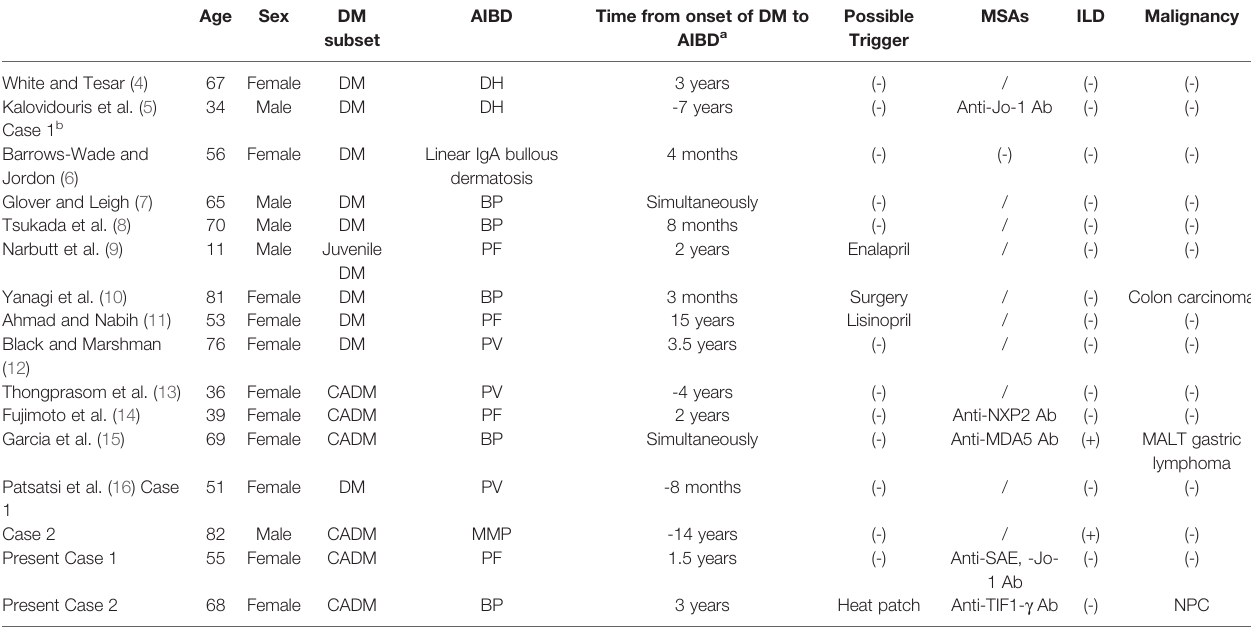
DM,dermatomyositis;AIBDs,autoimmuneblisteringdiseases;MSA,myositis-speci fi cantibody;CADM,clinicallyamyopathicdermatomyositis;ILD,interstitiallungdisease;DH,dermatitis herpetiformis; PV, pemphigus vulgaris; PF, pemphigus foliaceous; BP, bullous pemphigoid; MMP, mucous membrane pemphigoid; NPC, nasopharyngeal carcinoma; MALT, mucosa- associated lymphatic tissue; NXP2, nuclear matrix protein 2; MDA5, melanoma differentiation-associated gene 5; SAE, small ubiquitin-like modi fi er activating enzyme; TIF1, transcription intermediary factor 1. a Time span from the onset of fi rst symptom assumed to be related to DM to AIBD, the symbol “ - ” means AIBD occurred before DM. b Case 2 in this literature was